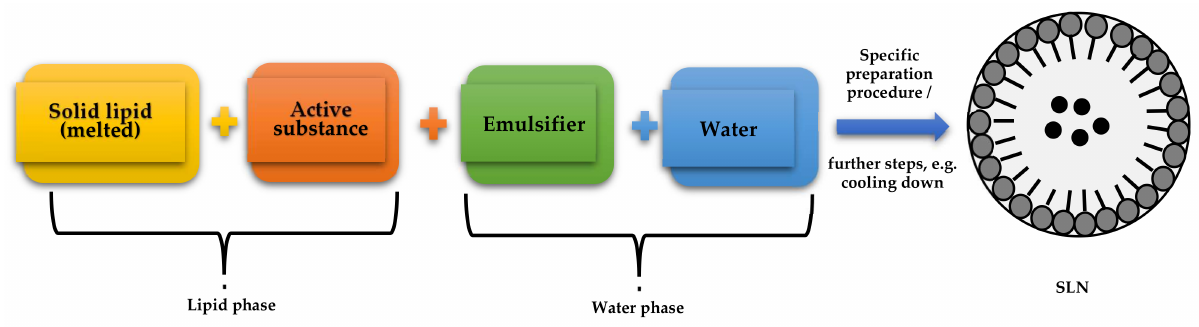
Scheme 1. Block diagram of the structure of a solid lipid nanoparticle. Based on